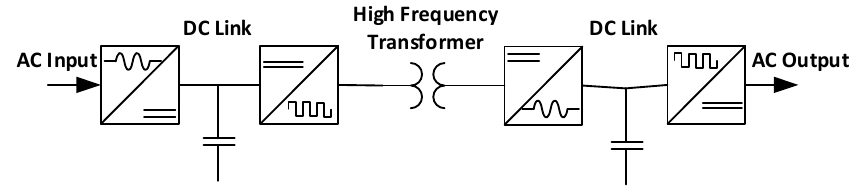
Figure 3. Power–electronic interface schematic.